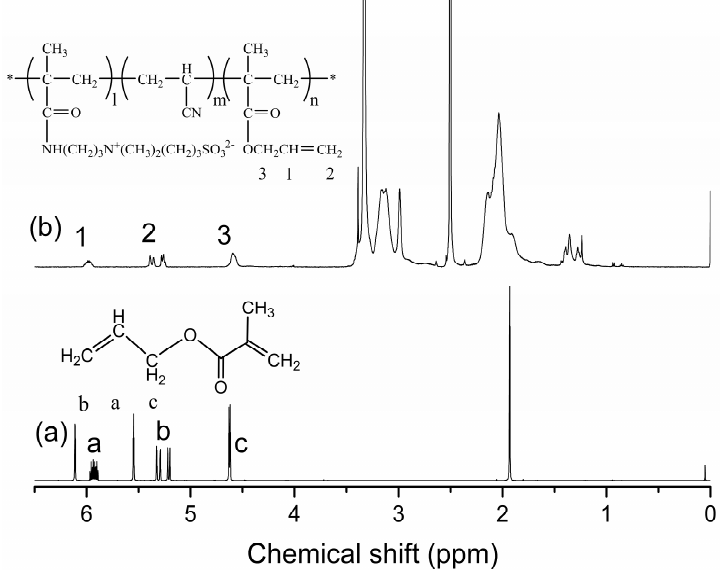
Figure 3. 1 H-NMR spectra of ( a ) monomer AMA, and ( b ) P(AN-co-SBMAA-co-AMA) copolymers.